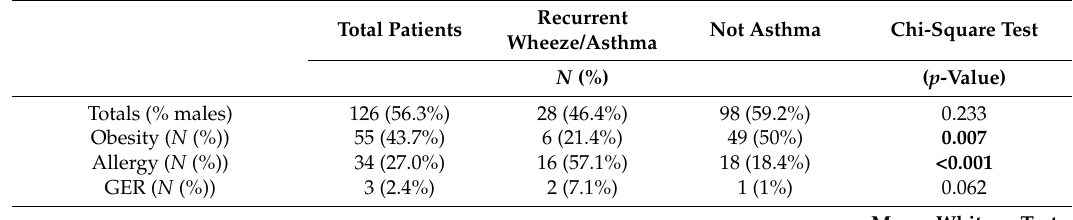
Table 1. Summary of the demographic and clinical characteristics of the children enrolled in the study. Obesity is defined as a BMI at or above the 95th percentile according to age and sex.